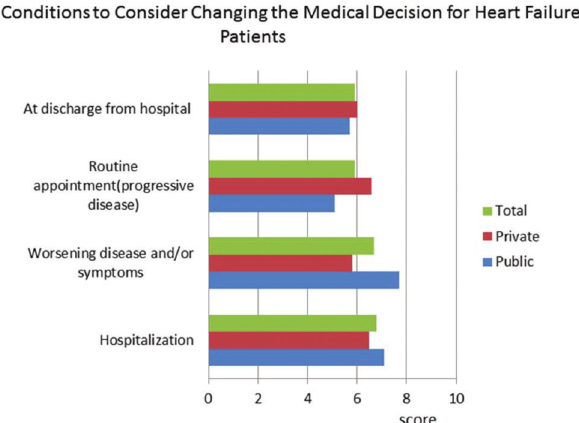
Figure 5 - Perceptions of doctors in centers treating heart failure (HF) regarding the importance of conditions that lead to change in the management of HF